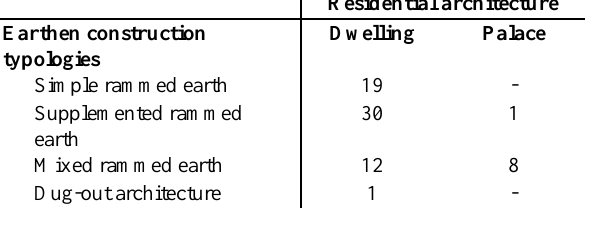
Table 1. The relation between the earthen construction typologies and residential architecture.